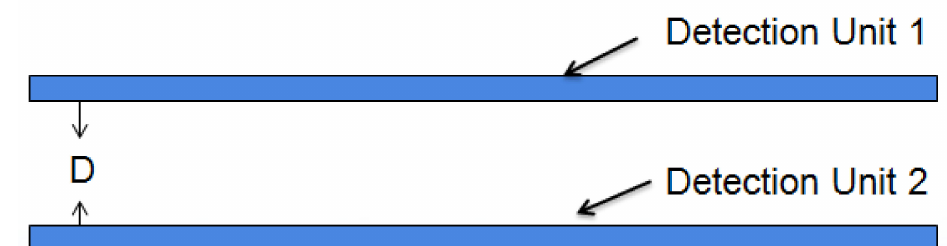
Figure 6. Diagram of the section on the side of the differential structure. Determination of center frequency: Before the D value was determined, the frequency of the probe’s operating center, namely, the incidence frequency of the radio-frequency signal source, had to be determined. As shown in Figure 7, at the center frequency of 100 MHz, the corresponding S11 (return loss) parameter was the smallest, at − 12.6 dB. Therefore, the center frequency of the radio-frequency signal source was 100 MHz.